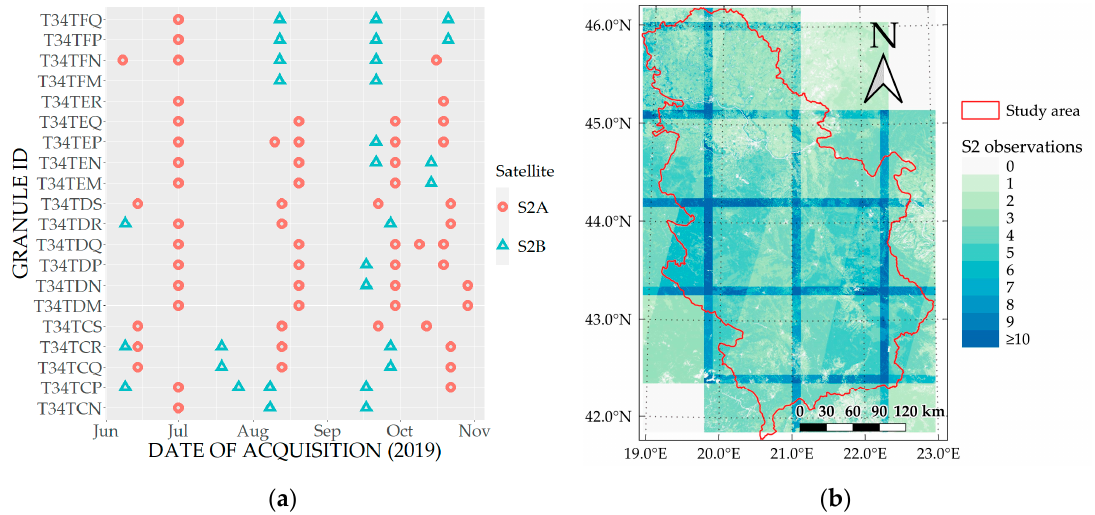
Figure 2. The used Sentinel-2 granules over the study area: ( a ) Timestamps the granules; ( b ) Number of Sentinel-2 observations available over the study area.